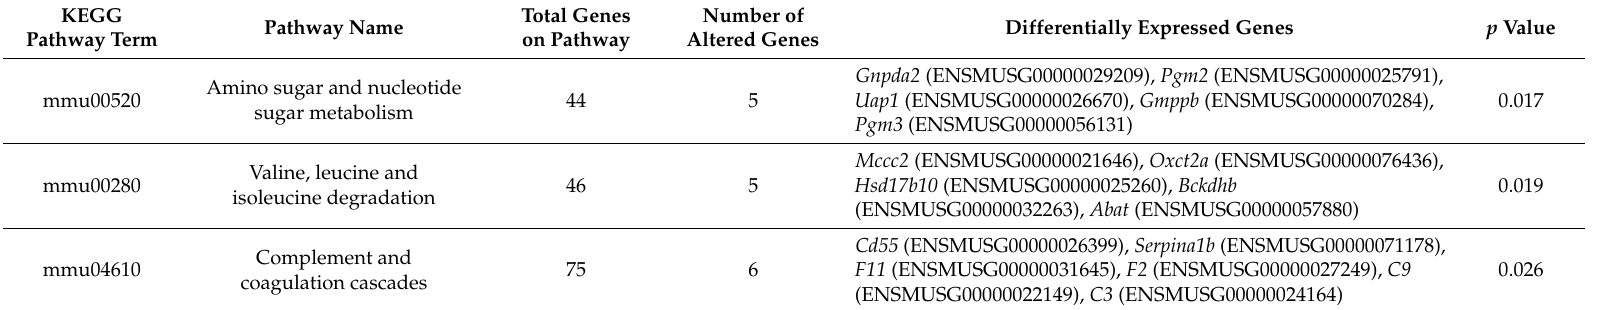
Table 6. WikiPathways in the placenta altered by maternal folate depletion 1,2 during pregnancy and identified using PathVisio. Number of Genes Number of Genes Total Number of Pathway % Affected Z Score p -Value (Permuted) Altered on Pathway Measured on Pathway Genes on Pathway Complement Activation, Classical Pathway 3 13 Statin Pathway 3